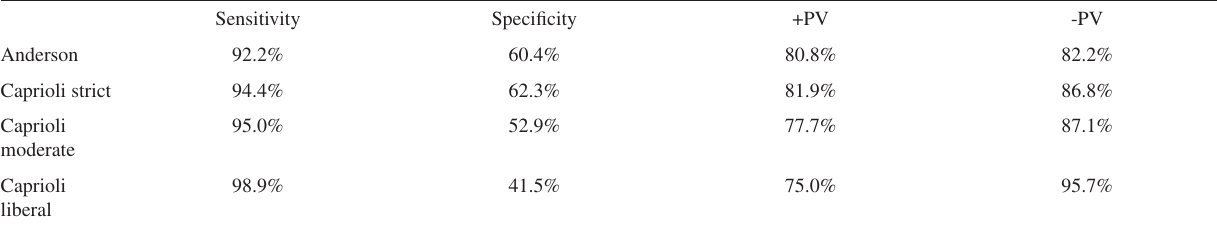
Table 2 - Sensitivity, specificity and predictive values of different analytic algorithms for SITA interpretation